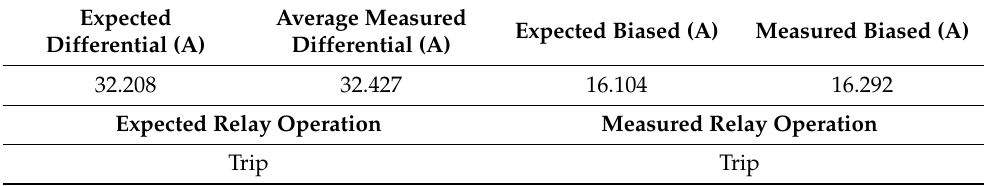
Table 5. Results comparison for the unstable condition.